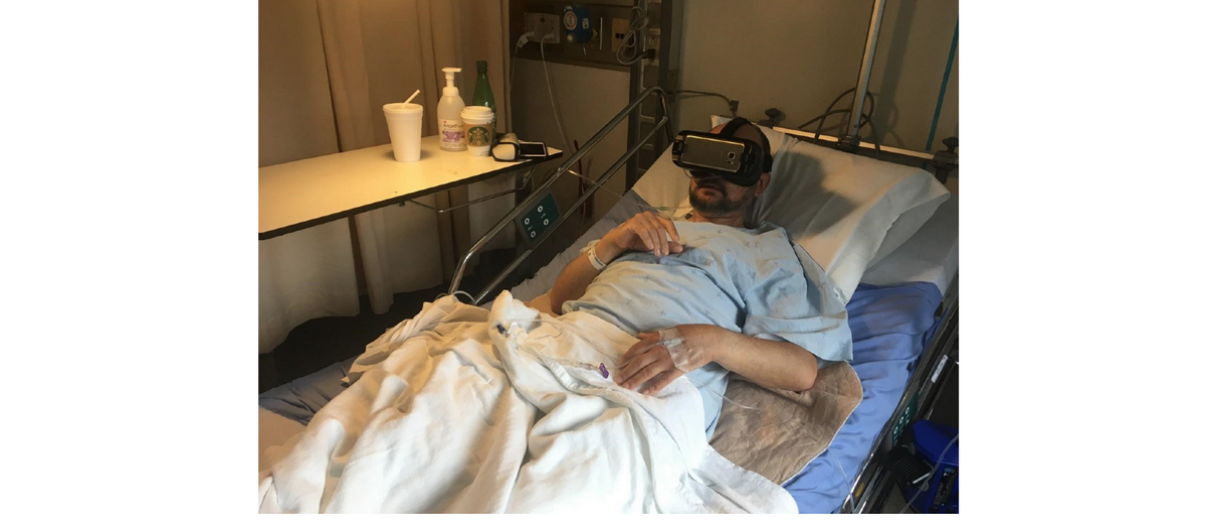
Figure 2. Participant tries the virtual reality experience. Written informed consent was obtained from the individual for the publication of this image.